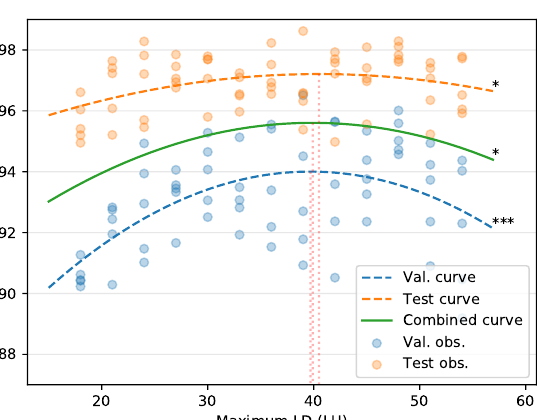
Val. curve Test curve Combined curve Val. obs. Test obs.